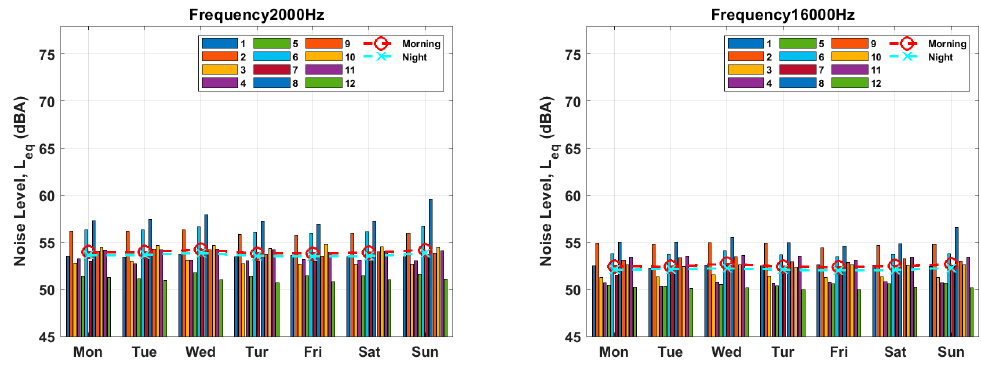
Figure 7. Daily average at 2000 Hz and 16,000 Hz in one week for different sensors.